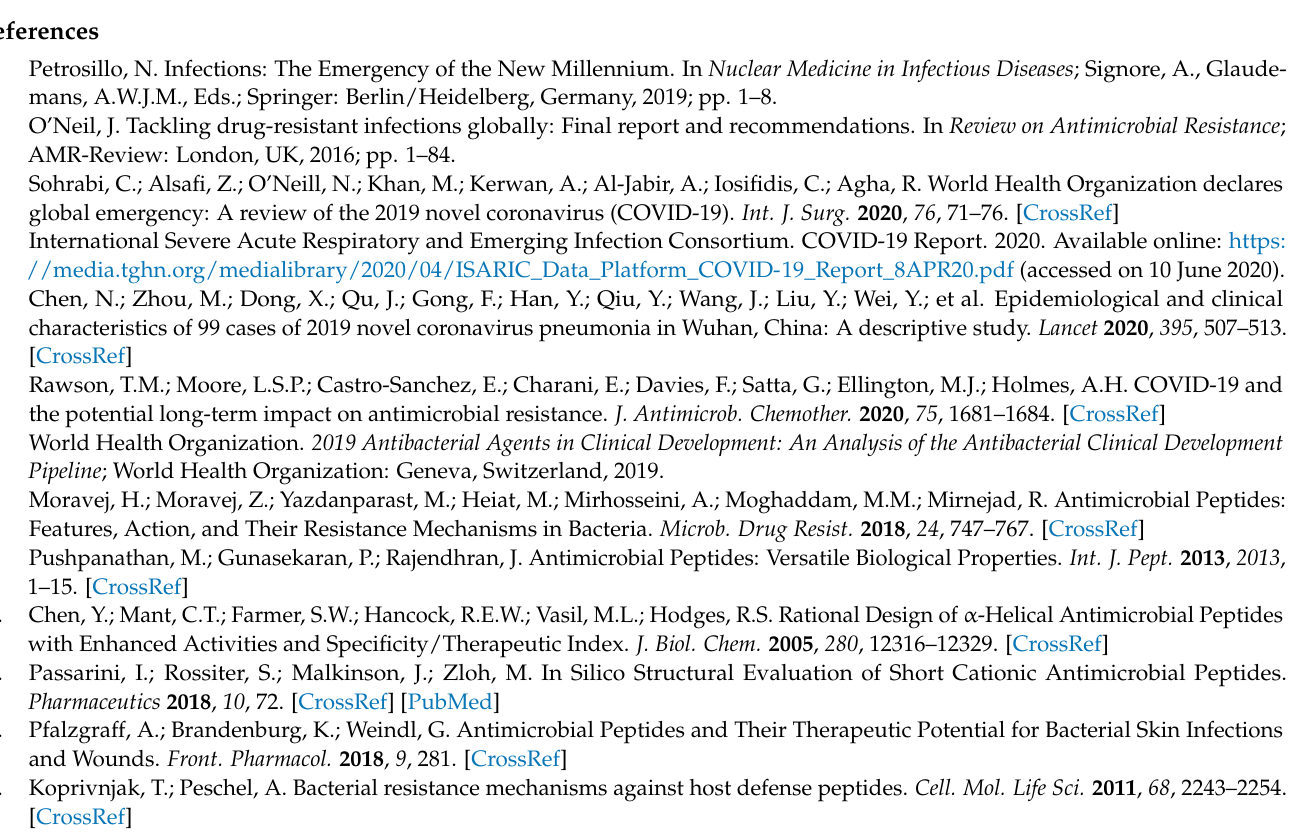
X/11/3/471/s1, Code S1: Code for generative model, Code S2: Code for classification model, Figure S1: Histogram of the length distribution of the positive data set, Figure S2: Histogram of the MIC distribution of the positive data set, Figure S3: Histogram of the length distribution of the negative UniProt data set, Figure S4: Histogram of the length distribution of the negative AMP data set, Table S1: Generative model hyperparameters optimised with Bayesian hyperparameter optimisation, Table S2: Classification model hyperparameters optimised with Bayesian hyperparameter optimisation, Table S3: Performance comparison of our classification models with other state-of-the-art machine learning models, Table S4. Predictions of the 14 AMP (antimicrobial peptide) sequences in the case study, by external AMP classification